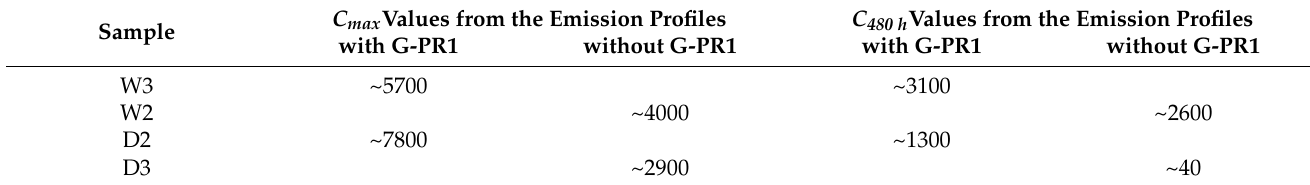
Table 6. Increase of TVOC concentration C max and C 480 ( µ g m − 3 ) caused by a change in the multilayer sample structure oftype D or W to the chemical composition of one layer: a primer (air exchange n = 0.5).